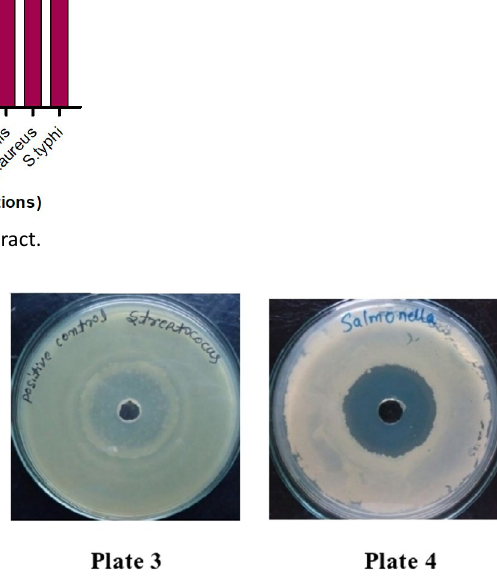
Fig. 4. Plate 1 & 2. Anti-Bacterial Activity of Ofloxacin against E. coli and B. subtilis